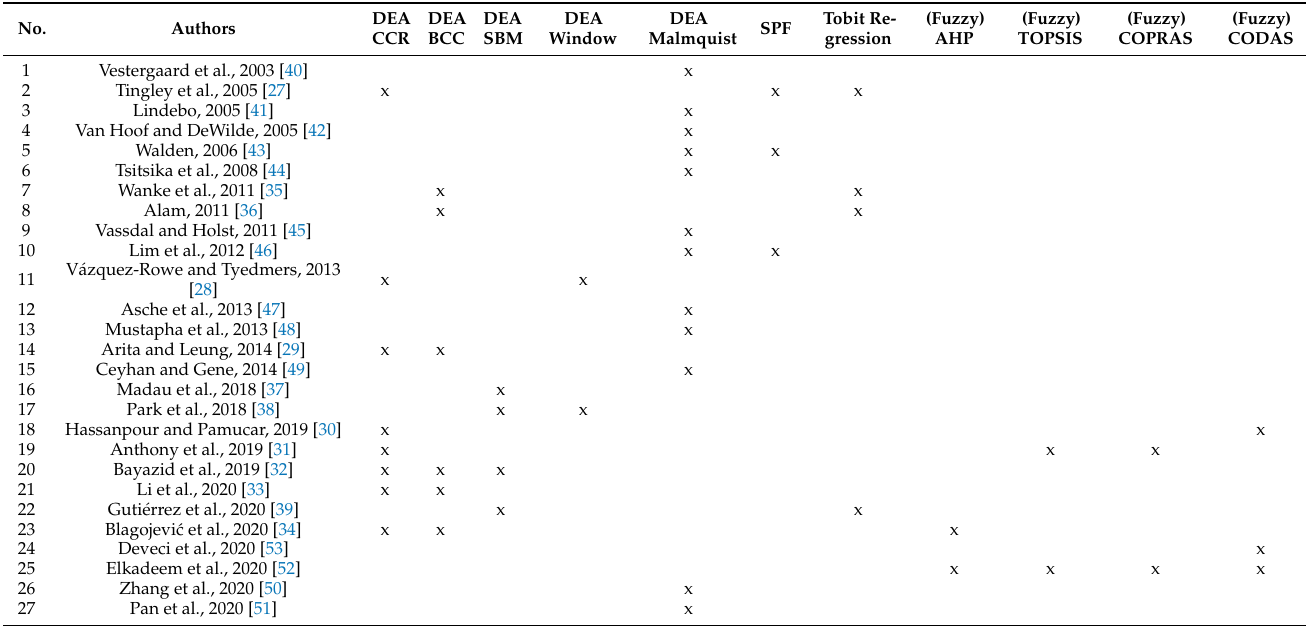
Table 1. List of method approach for relevant previous